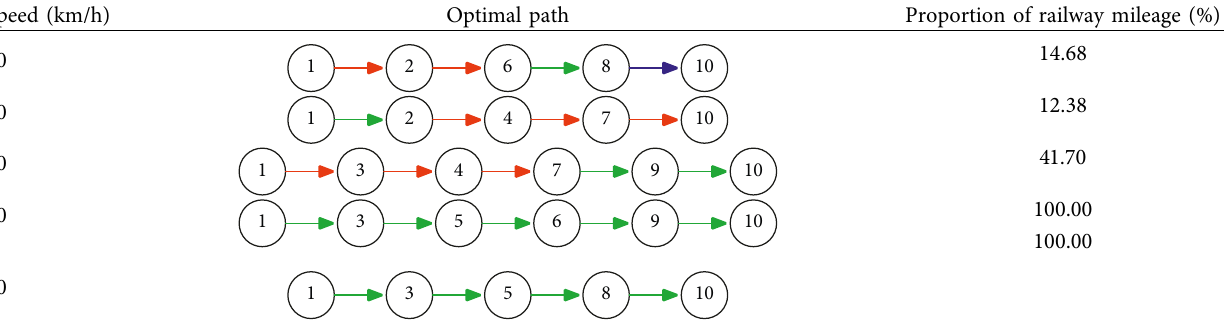
Table 7: Changes in the optimal path with railway transport speed.